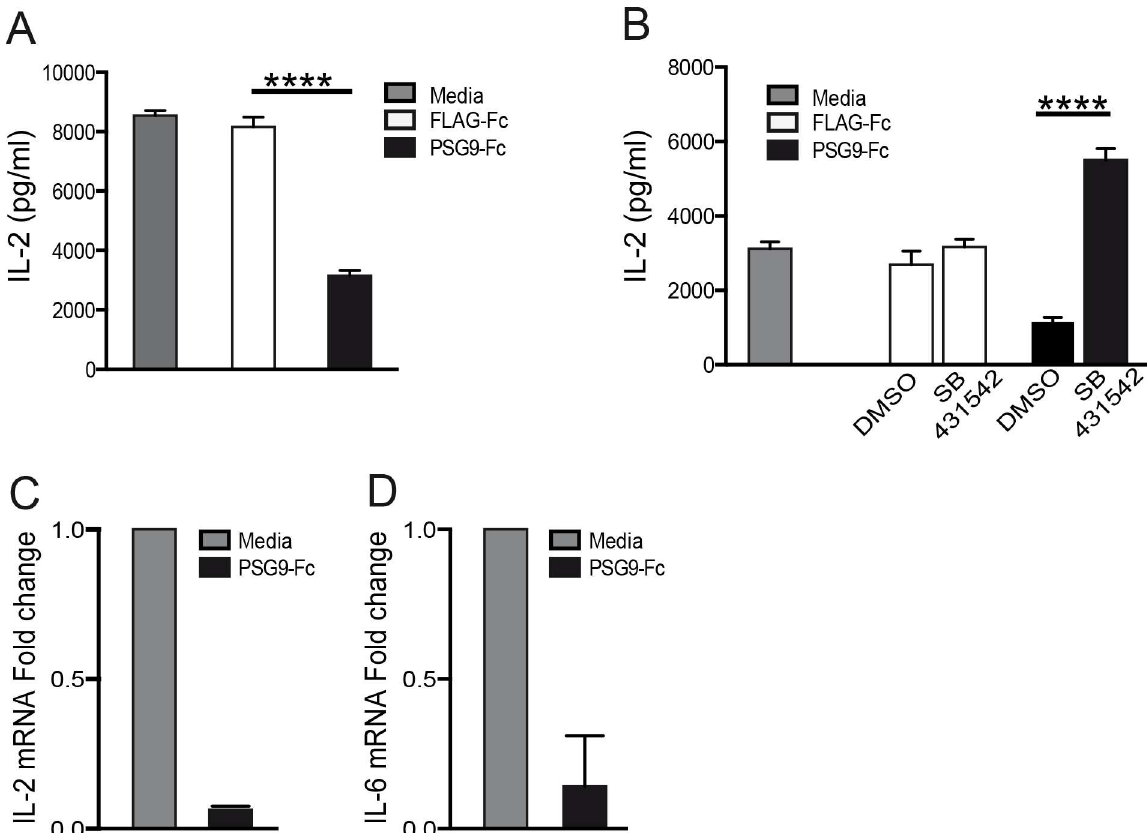
Fig 7. Administration of PSG9 to naive mouse CD4 + T-cells inhibits IL-2 expression. (A) Cells collectedfrom normal C57BL/6 mouse spleenswere treated with equimolar concentration of PSG9 or FLAG control protein and activated with mouse CD3/CD28 T- cell activator Dynabeads. IL-2 levels were determined by ELISA 72 h after activation. P value was calculatedusing the Student’s t - test, P < 0.0001. (B) Cells were collected,activated, and treated with FLAG or PSG9 as in A in presence of a TGF- β receptor I inhibitor (SB431542) or vehicle (DMSO). IL-2 levels were measuredin the supernatant by ELISA 72 h after activation. P value was calculated using one-wayANOVA, P < 0.0001. (C) IL-2 and IL-6 mRNA levels were evaluatedby RT-PCR from mouse naive CD4 + T-cells treated with PSG9 or media. P value was calculatedusing the Student’s t -test, P < 0.005. Data shown are representative of at least three